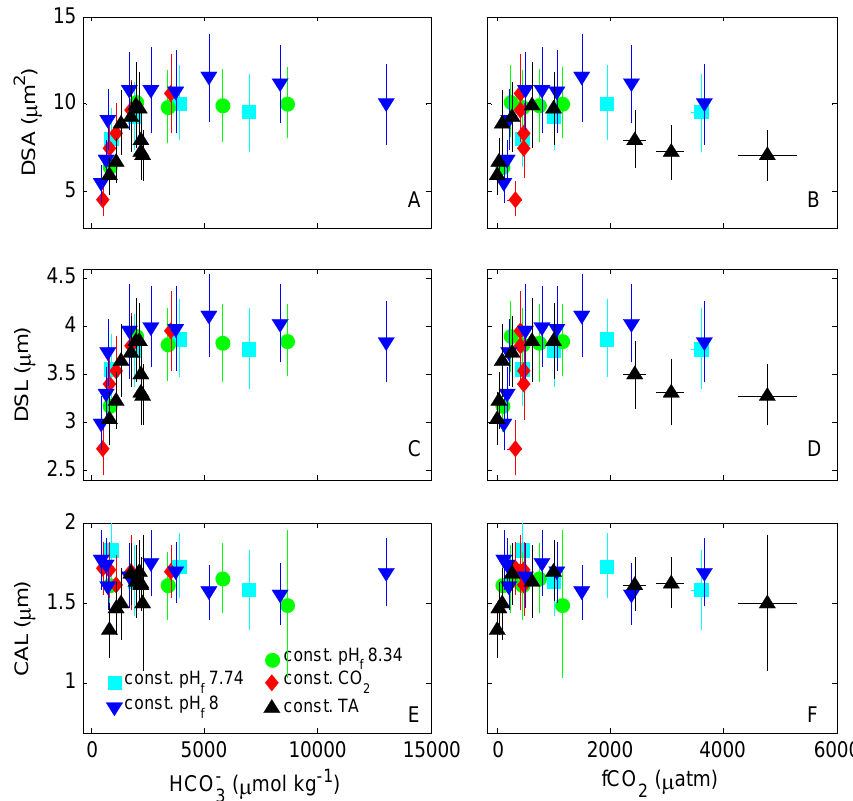
Fig. 5. Coccolith size (DSA, DSL, and DSW) as a function of carbonate chemistry speciation. (A, C, E) in relation to HCO 3- . (B, D, F) in relation to fCO 2 . Symbol size and color coding shown in panel E. Error bars denote the standard deviation from measured mean size of all coccoliths in a treatment.